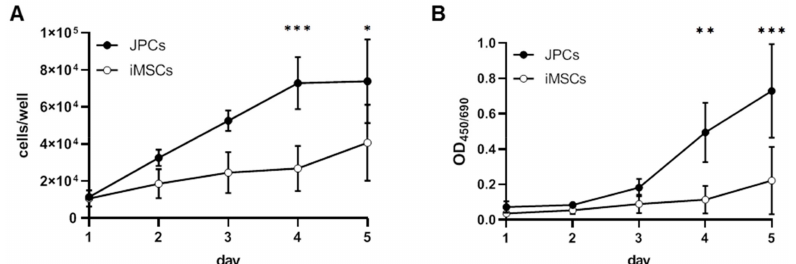
Figure 5. Growth kinetics and mitochondrial activity of JPCs and iMSCs. Quantification of ( A ) cell growth by cell counting and ( B ) mitochondrial activity by colorimetric measurement of formazan derivates produced by reduction of tetrazolium salts in the mitochondria of JPCs and iMSCs (EZ4U). Cell numbers and mitochondrial activities of iPSCs and JPCs were compared by two-way ANOVA ( n = 3, * p < 0.05, ** p < 0.01, *** p < 0.001).